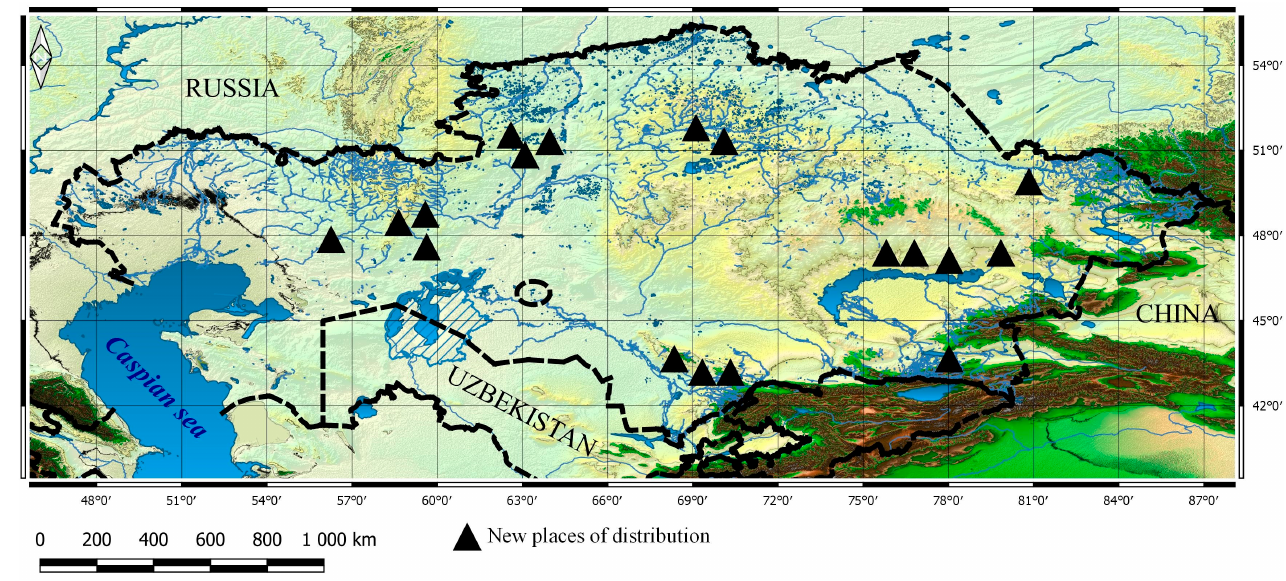
Figure 4. Distribution of Dactylorhiza incarnata (L.) Soó in Kazakhstan. 3.2.2. Dactylorhiza salina (Turcz. ex Lindl.) Soó, Nom. Nov. Gen. Dactylorhiza: 4 (1962).